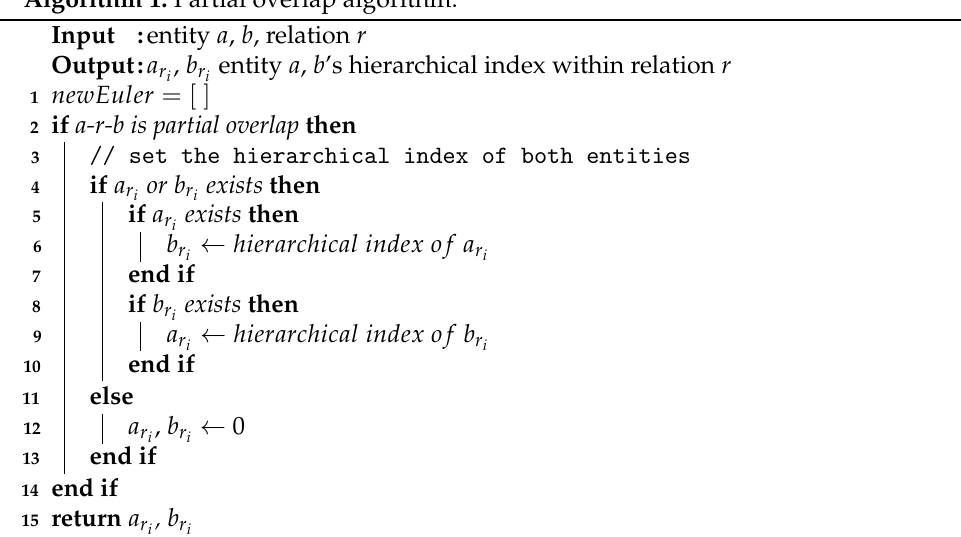
Figure 5. Triple A :loves B. Algorithm 1: Partial overlap